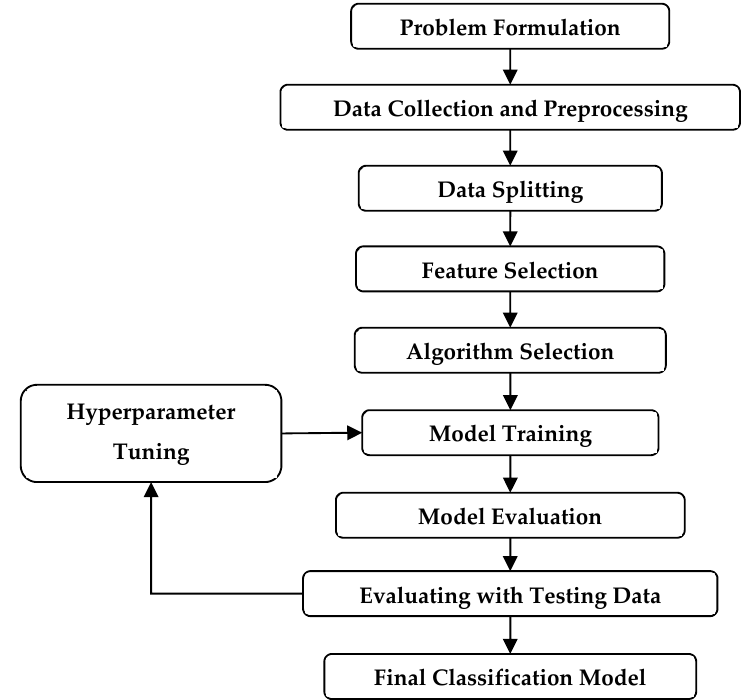
Figure 1. Main steps of the proposed research with machine learning methodology.